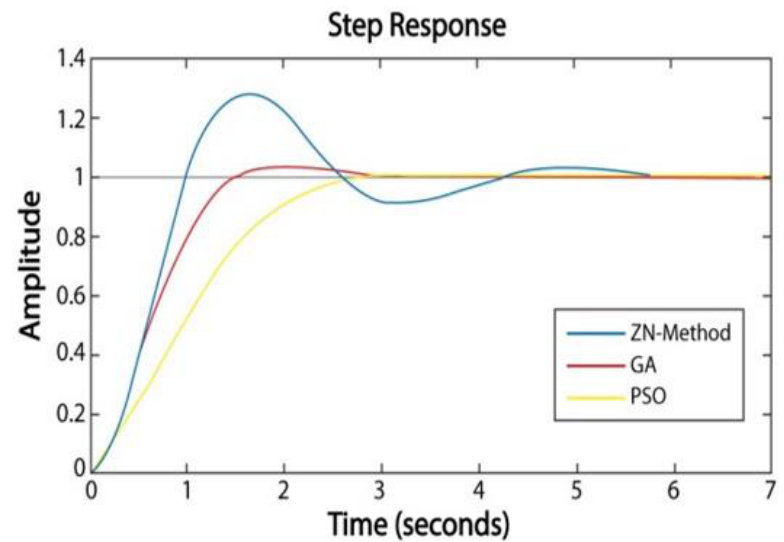
Figure 11. Comparison of the modelling step response for PID controller.